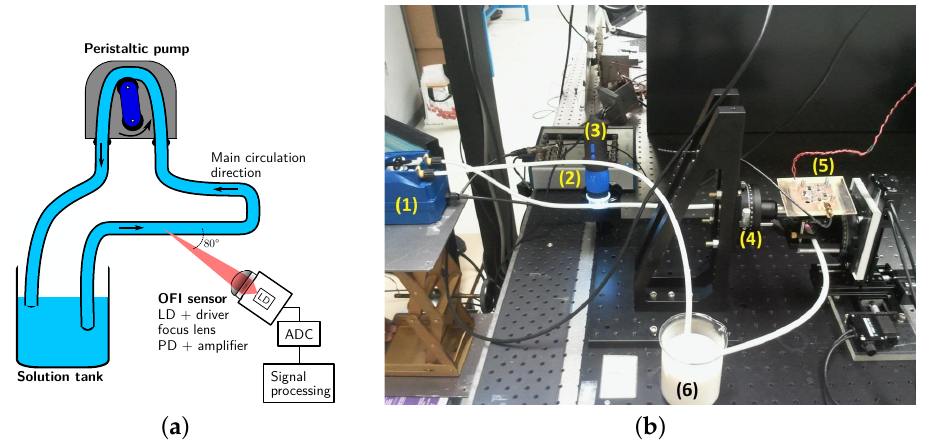
Figure 13. ( a ) Description of the milli-fluidic circuit with the associated OFI sensor; ( b ) photography of the experimental setup with: (1) the peristaltic pump; (2) the USB camera; (3) the NI-6361 ADC board; (4) the goniometer; (5) the OFI sensor; and (6) the solution